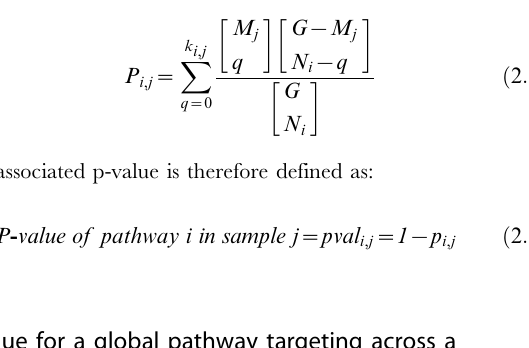
Table S1 Bonferroni correction was applied on the p-values calculated using the Fisher Omnibus test in order to address the problem of multiple comparisons. The value for significance was assign to be 8.834 6 10 2 5 , which is 0.05/566 (when 566 is the number of pathways). Table S1 shows all 566 pathways calculated from Chin’s dataset with the p-value calculated via Fisher Omnibus test. In addition, every p-value was adjusted and pathway significance was reassigned.